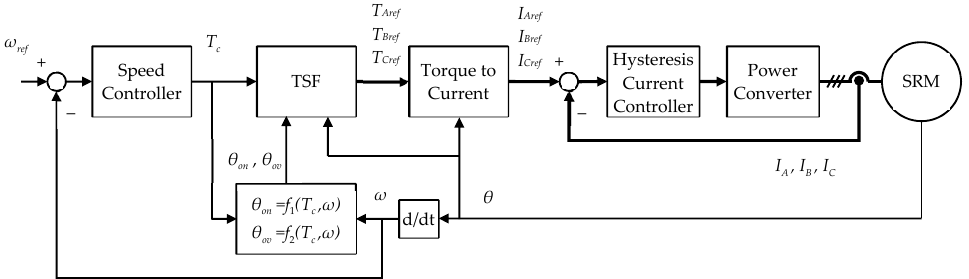
Figure 5. Block diagram of the switched reluctance motor (SRM) control using torque sharing function (TSF) with optimized parameters θ on and θ ov .